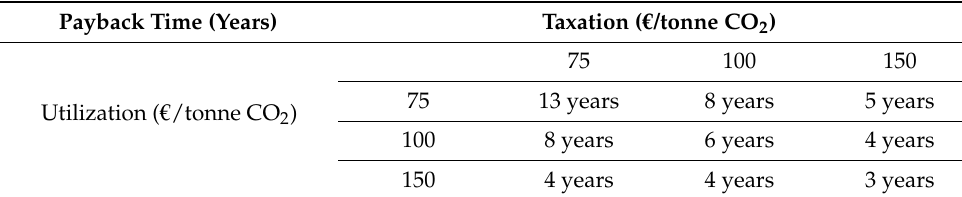
Table 4. Effect on payback time from variations of case study